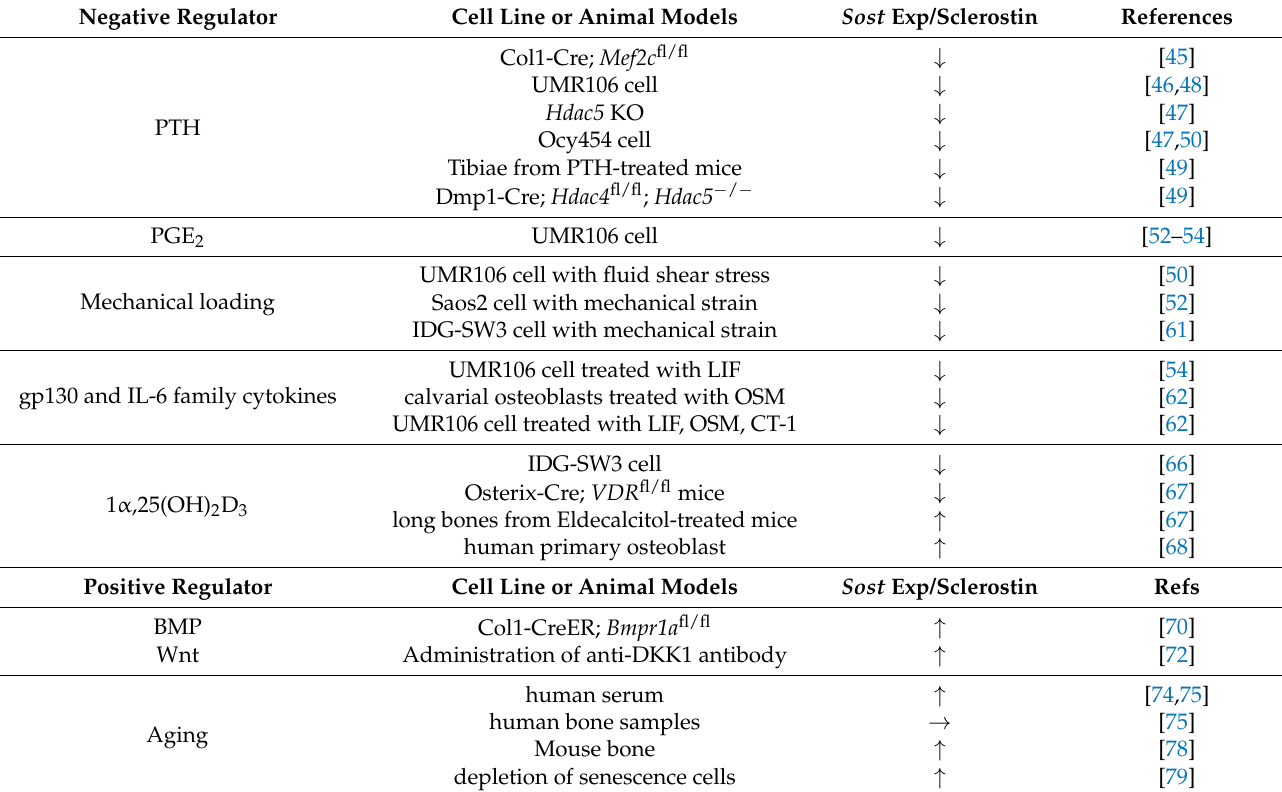
Table 1. Regulators of sclerostin